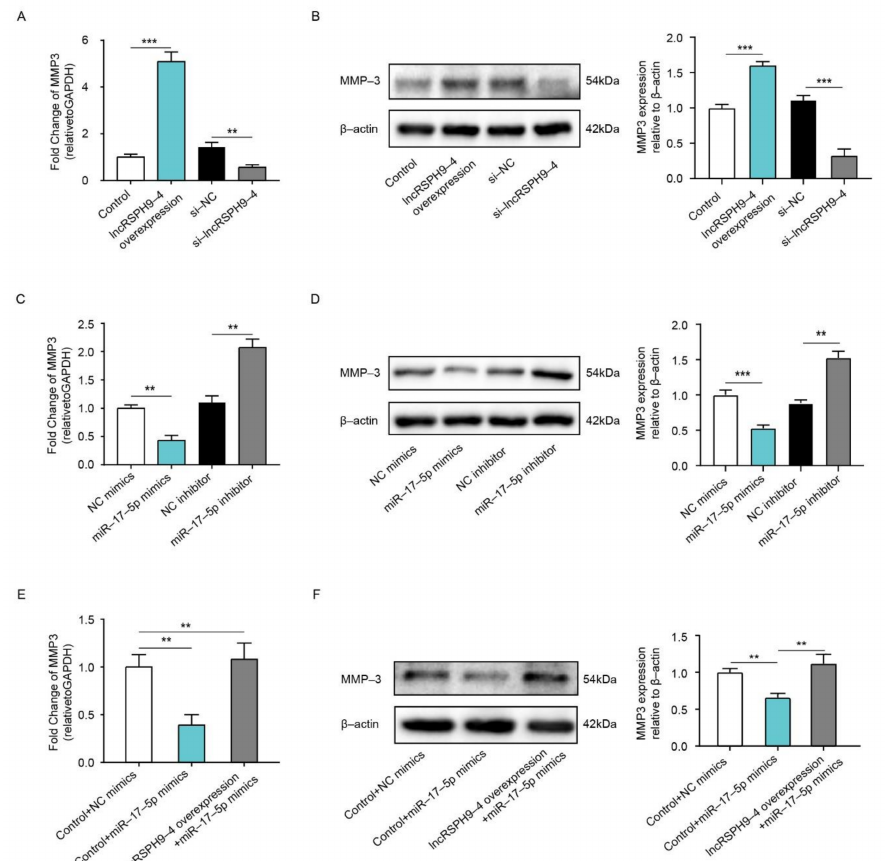
Figure 6. LncRSPH9-4 overexpression increased MMP3 expression via miR-17-5p . ( A , B ) The transcription and expression levels of MMP3 in hBMECs with lncRSPH9-4 overexpression or silencing by qPCR and Western blot analyses. GAPDH was used as the reference control for the qPCR, β -actin was the loading control for the blotting and densitometry was performed to analyze differences. The qPCR data were presented as mean ± SD from three independent assays. ** p < 0.01; *** p < 0.001. ( C , D ) The transcription and expression levels of MMP3 in hBMECs with miR-17-5p overexpression or inhibition by qPCR and Western blot analyses. GAPDH was used as the reference control for the qPCR, β -actin was the loading control for the blotting and densitometry was performed to analyze differences. The qPCR data were presented as mean ± SD from three independent assays. ** p < 0.01; *** p < 0.001. ( E , F ) The transcription and expression levels of MMP3 in hBMECs with miR-17-5p mimics transfection or with both miR-17-5p mimics and lncRSPH9-4 co-transfection, determined by qPCR and Western blotting. GAPDH was used as the reference control for the qPCR, β -actin was the loading control for the blotting and densitometry was performed to analyze differences. The qPCR data were presented as mean ± SD from three independent assays. ** p <